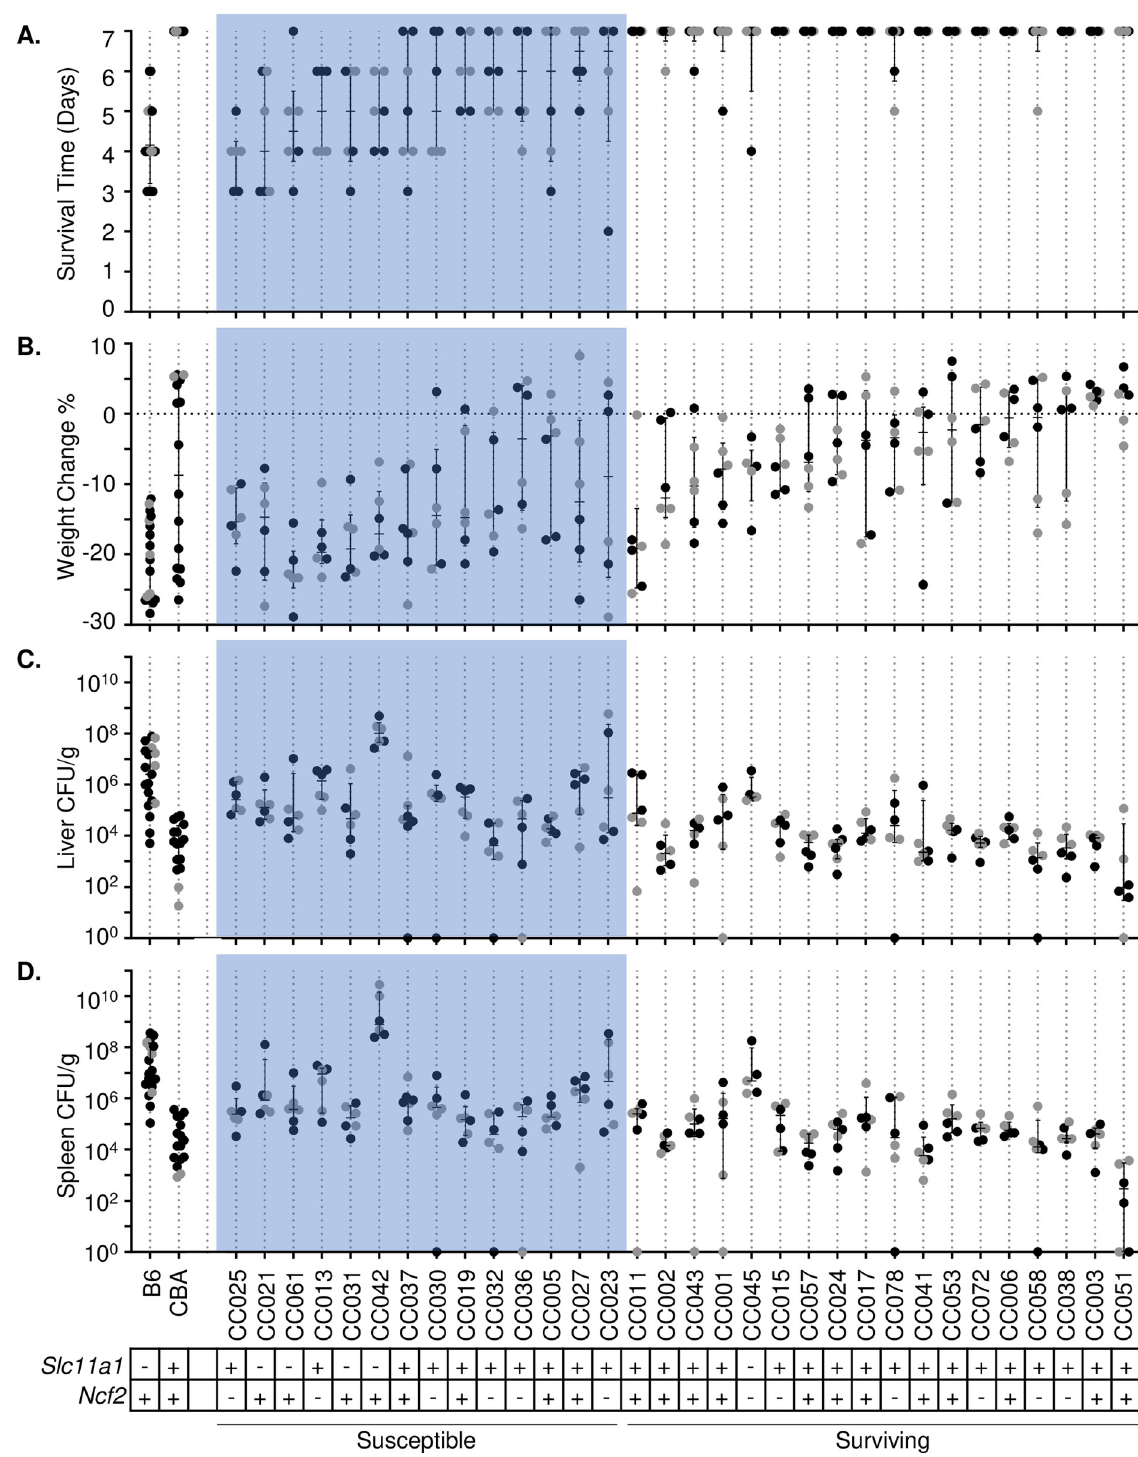
Fig 2. CC strains have variable responses to STm infection. A. Survival time and B. percent weight change after infection with STm. Strains are in ascending order of survival and weight change if survival was equal between strains. Bacterial burden in C. liver and D. spleen. Dots represent individual mice; black dots represent males and grey dots represent females. Median and interquartile range are shown by lines for each strain. Slc11a1 and Ncf2 status shown by +/-. 32 CC strains and 2 controls (B6 and CBA) represented.